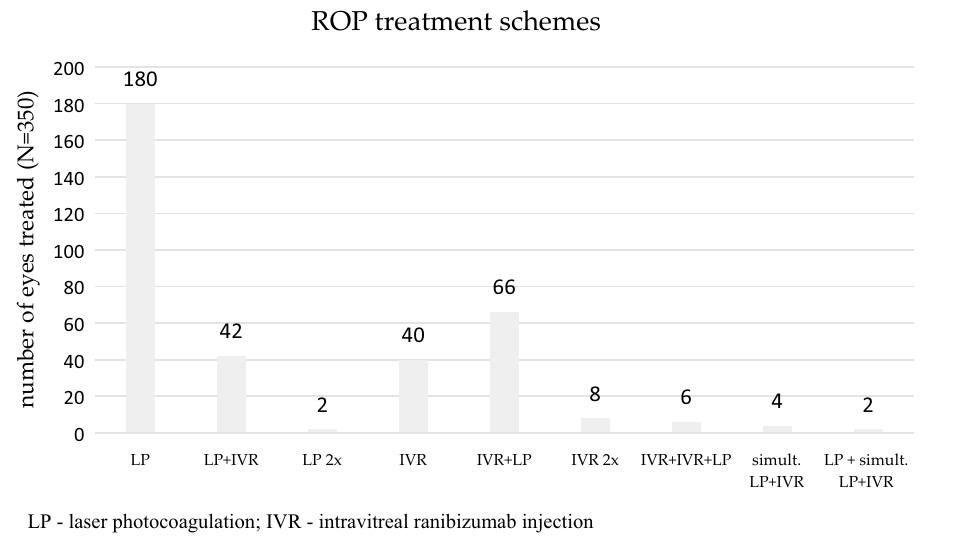
Figure 2. Distribution of treatment modalities for ROP patients in the years